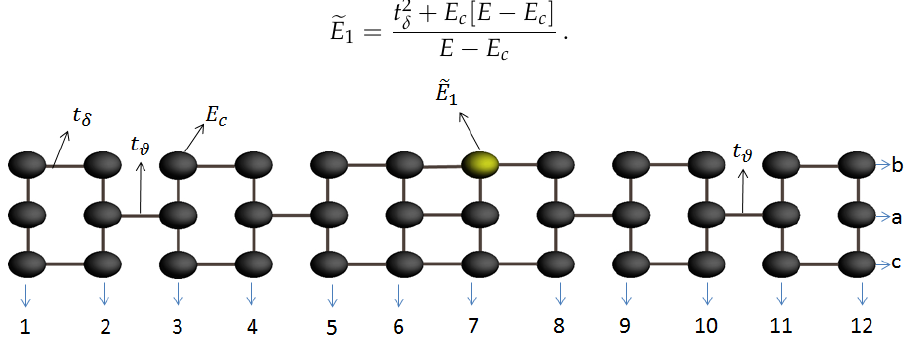
Figure A2. Geometric rearrangement of the 2,7-Di([1,1 (cid:48) -biphenyl]-4-yl)-9H-fluorene molecule without